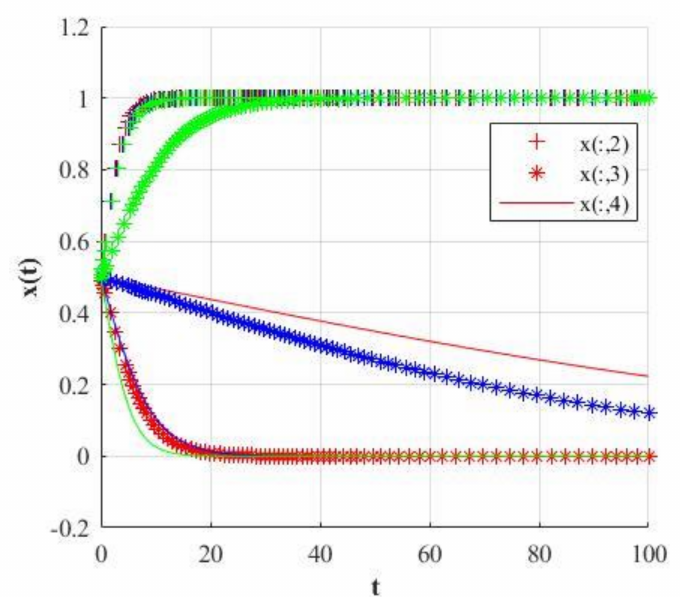
Figure 23. Change the parameter δ 2 = 0.2 (red curve), 0.6 ((blue curve), 0.9 (green curve) to take the value of the three-way strategy evolution diagram.